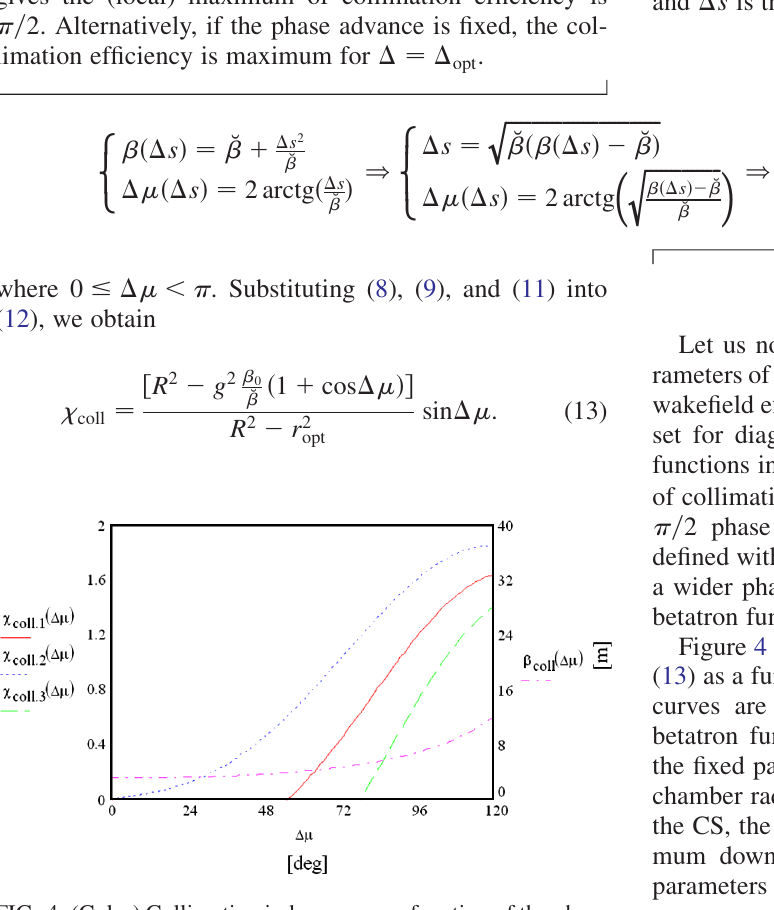
FIG. 4. (Color) Collimation index (cid:8) as a function of the phase coll TABLE I. CS fixed advance between C1 and C2. The solid curve refers to the optimum set of parameters (nominal collimator half-aperture ¼ ¼ 1 at 90 deg. The dotted curve and the dashed 1 : 4 mm ): (cid:8) coll curve refer to a smaller (1.2 mm) and a bigger (1.6 mm) can collimator half aperture, respectively. In these cases, (cid:8) coll be restored to 1 at 71.4 deg and at 104.4 deg phase advance, respectively. The bottom line shows the betatron function at the collimators’ location.